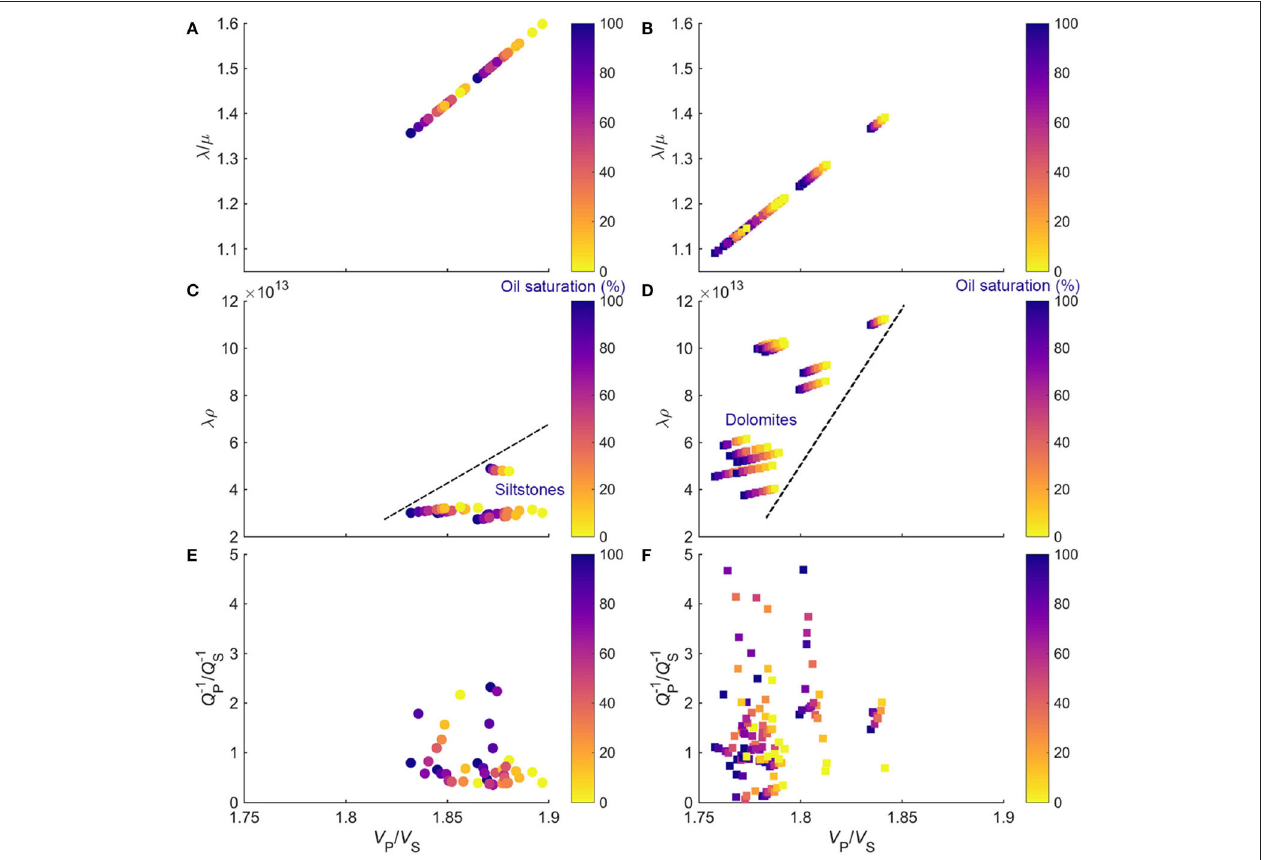
FIGURE 7 | Crossplots of λ/µ – V P / V S , λρ – V P / V S , and Q − 1 P / Q − 1 S – V P / V S for siltstones (A,C,E) and dolomites (B,D,F) at partial oil–water saturation. The color from yellow to purple denotes oil saturation increasing from 0 to 100%.